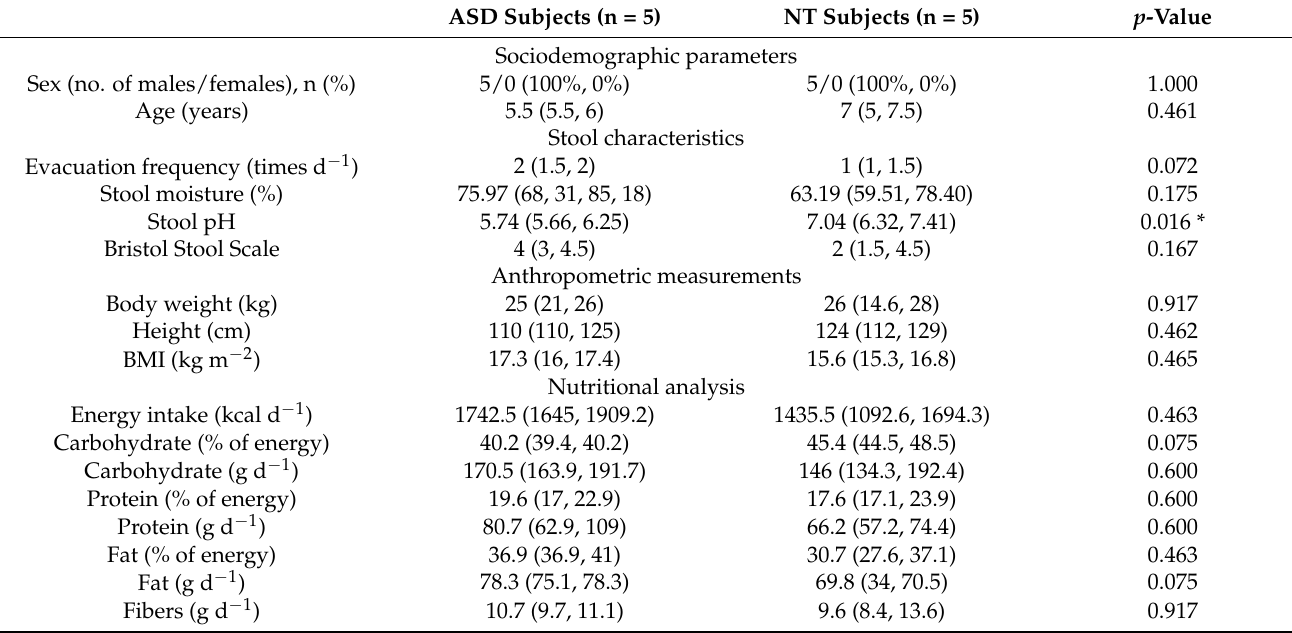
Table 3. Descriptive characteristics of fecal donors (n =